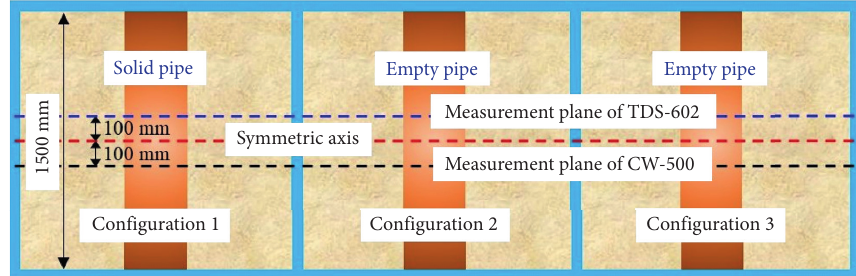
Figure 7: Arrangement of measurement